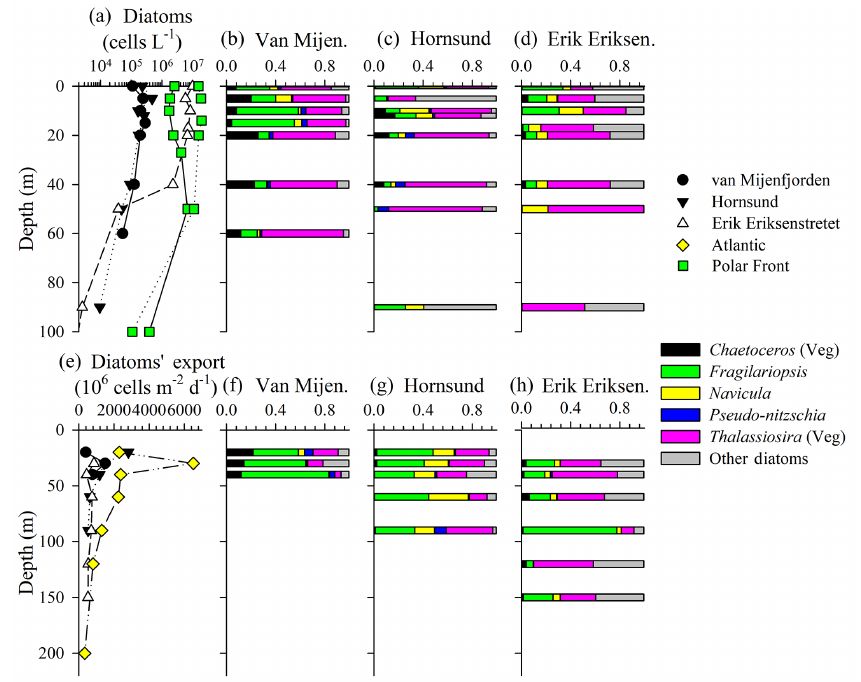
Figure 3. Diatom abundance (a) and assemblage composition (b–d) in the water column, and diatom export (e) and assemblage composi- tion (f–h) within sediment traps. Note – taxonomy information only shown for stations where both water-column and sediment-trap data were available (see text for species). Resting spores (e.g., Chaetoceros , Thalassiosira ) were absent from the 40m sediment traps; thus, pro- portional abundances for spore-producing taxa are entirely for vegetative cells. For (a) , there are replicate diatom abundance measurements (from separate hydrocasts) for the Polar Front